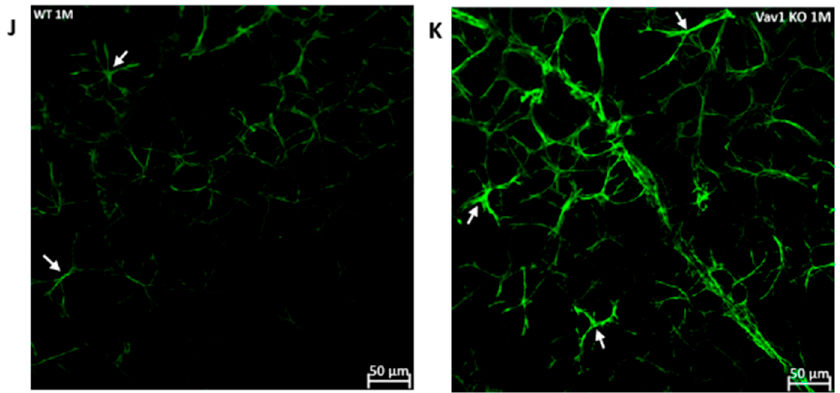
Figure 5. Loss of hematopoietic cells in the developing retina delays retinal vascular development and increases inflammation. Representative images ( A , B ) showing retinal flat mounts of WT and Vav1 KO retinas stained with collagen IV which labels the vasculature, and the corresponding outputs from VESGEN ( C , D ) showing the different vessel generations color coded ( E ) from 1 − 9. ( F − I ) Graphs showing VESGEN quantifications comparing total vessel number density, large vessel, medium-sized vessel and small vessel densities between the two groups. ( J , K ) Representative images showing GFAP expression (green) in the retinas of WT and Vav1 KO mice and the corresponding quantification in ( L ). White arrows indicate retinal astrocytes.